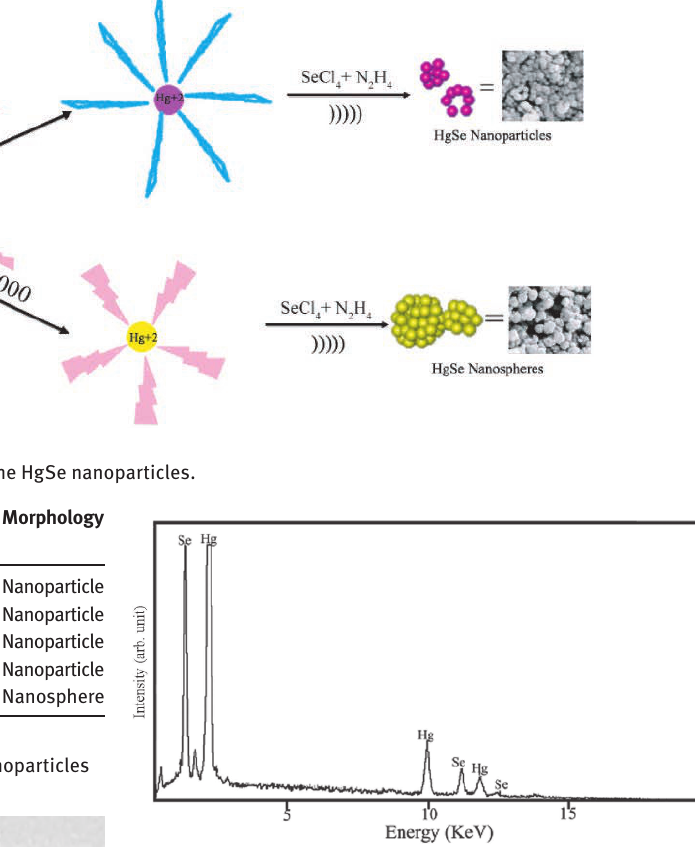
Fig. 6: EDS pattern of the HgSe (no.